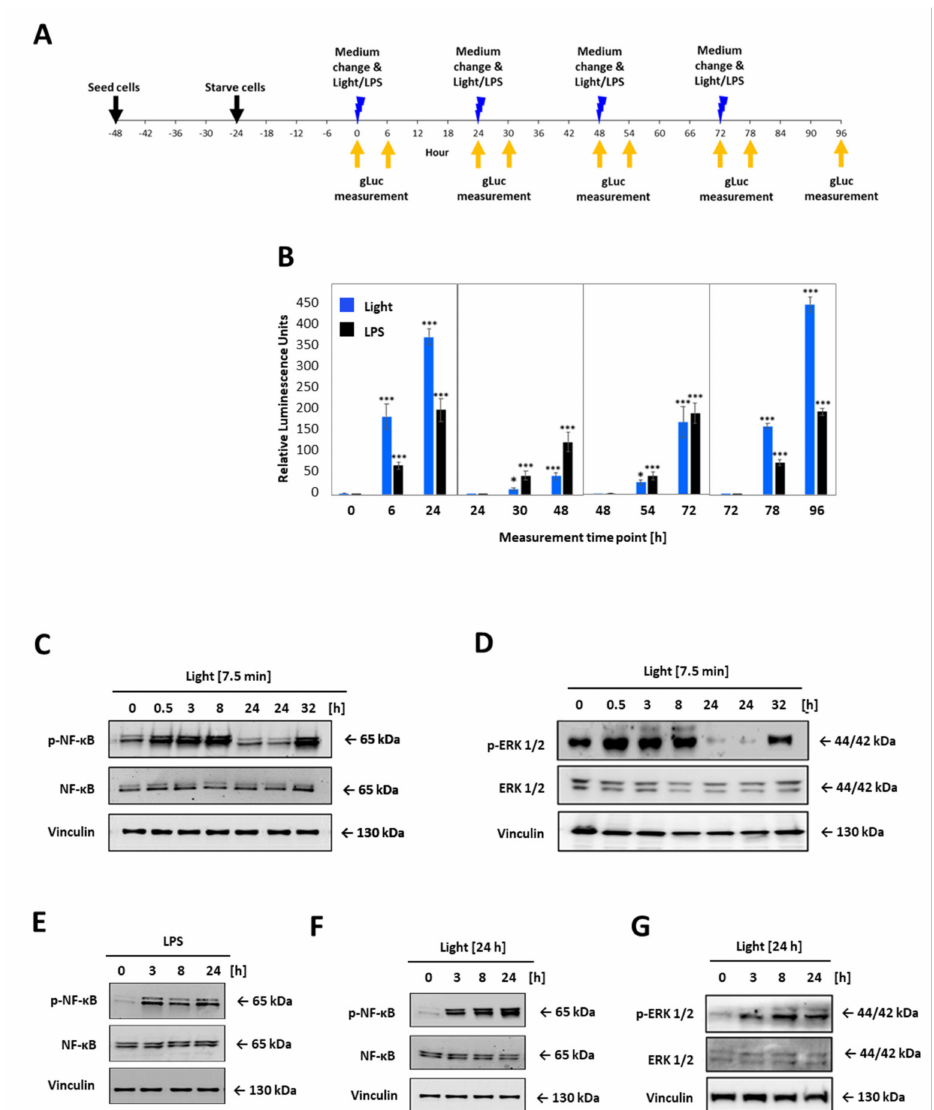
Figure 5. Comparative time-curve and re-activation analysis of opto-TLR4 PANC-1 cell line. Cells were exposed to light at 470 nm for 7.5 min or treated with 100 ng/mL LPS and incubated for 24 h in the dark before cells were again stimulated with light or LPS, respectively. Gluc was measured 6 h and 24 h after each stimulation. ( A ) Timeline for opto-TLR4 PANC-1 cell seeding, treatment, and imaging. ( B ) Gluc activity. Western blots of whole-cell extracts of opto-TLR4 PANC-1 cell line after light exposure (470 nm) for 7.5 min at timepoints 0 and 24 prior to extraction of proteins. Blots were probed with antibodies against ( C ) phospho-p65, total p65, or ( D ) p-ERK1/2, ERK1/2, and vinculin as loading control. Cells were treated continuously with LPS (100 ng/mL) or with light (470 nm) for 24 h and cell extracts were blotted and probed with antibodies against ( E , F ) phosphor-p65 p65, and ( G ) phospho-ERK1/2, ERK1/2, and vinculin as loading control. Post-ANOVA multiple comparisons relative to the control were performed using Dunnett’s test. Error bar = SD. n = 6; * p < 0.05; *** p < 0.001. Next, cells were treated as before and protein expression of phospho-p65 and phospho- ERK1/2 was analysed 0.5 h, 3 h, 8 h, and 24 h after the first stimulation with light or LPS, respectively, and 8 h after the second stimulation (32 h). As shown in Figure 5C–G, phosphorylation of both proteins p65 and ERK1/2 could be turned on by light and off in